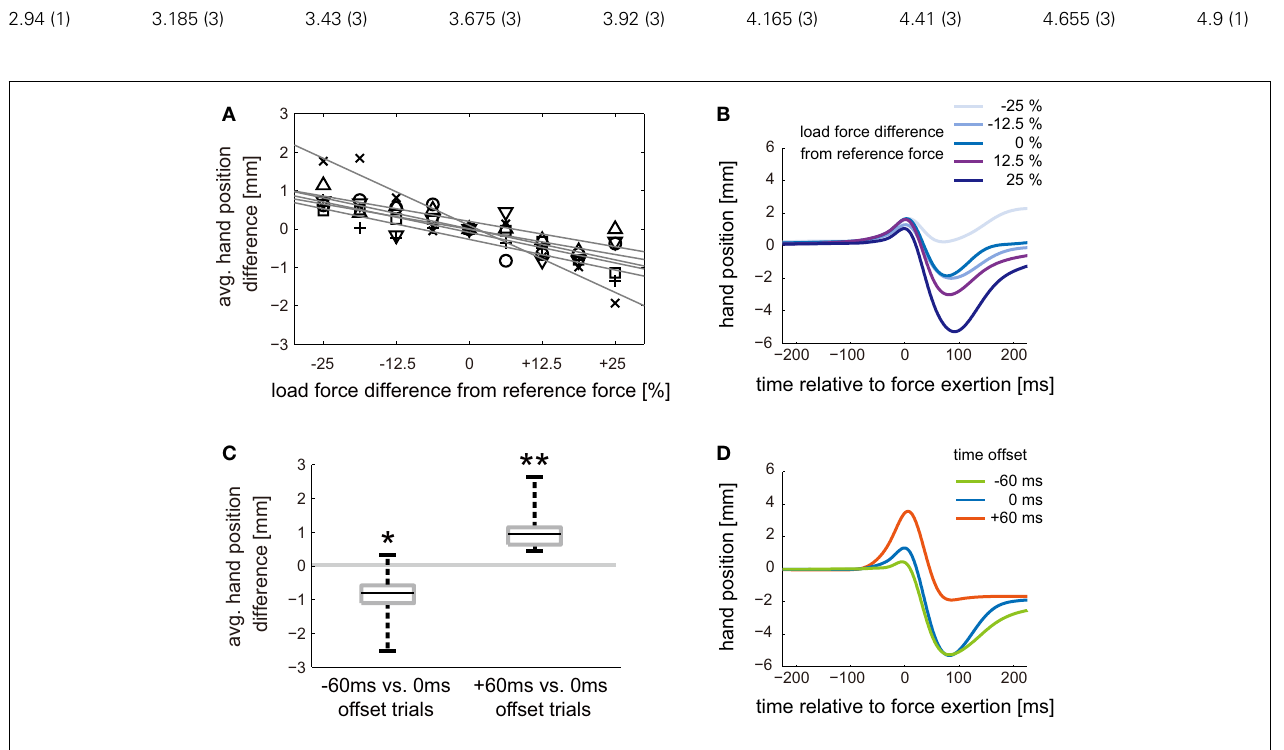
of 0ms offset trials with each of five different load force magnitude are aligned at the time of load force exertion.The data shown in the figure are the ones of a typical participant. (C) Trajectory difference caused by difference in time offset.The average hand position differences between average hand trajectory of 0ms offset with 3.92N force and those of − 60 and + 60ms with 3.92N force offsets are computed for each participant and plotted as box plots. Asterisks denote that the difference was significantly greater or less than zero: * P < 0.05, ** P < 0.01. (D) Typical hand trajectories for different time offsets. Average hand trajectories of − 60, 0, and + 60ms offset trials with 3.92N force are aligned at the time of load force exertion.The data shown in the figure are the ones of another typical